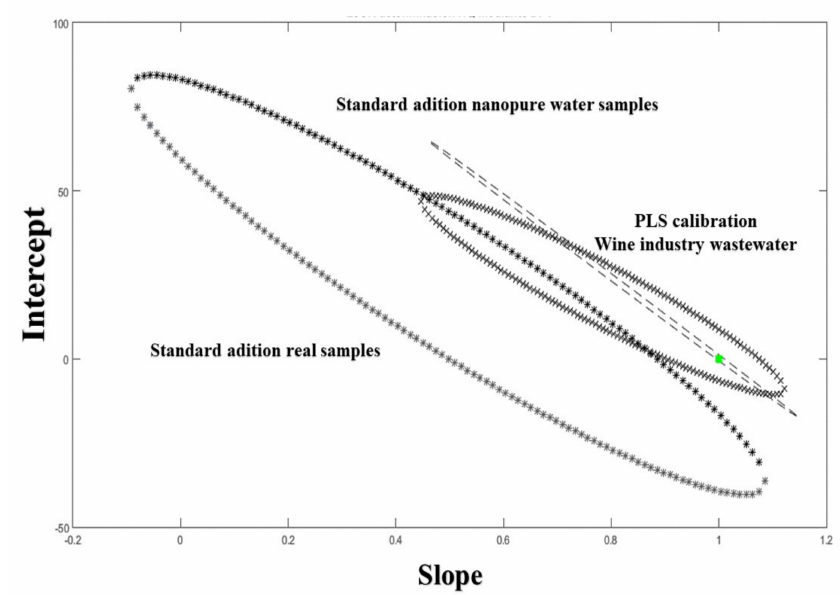
Figure 7. Elliptical joint region (at 95% confidence level) for the slope and intercept of predicted vs. nominal concentrations predicted by standard addition and the PLS model developed in this work. The green cross marks the theoretical (intercept = 0, slope = 1)